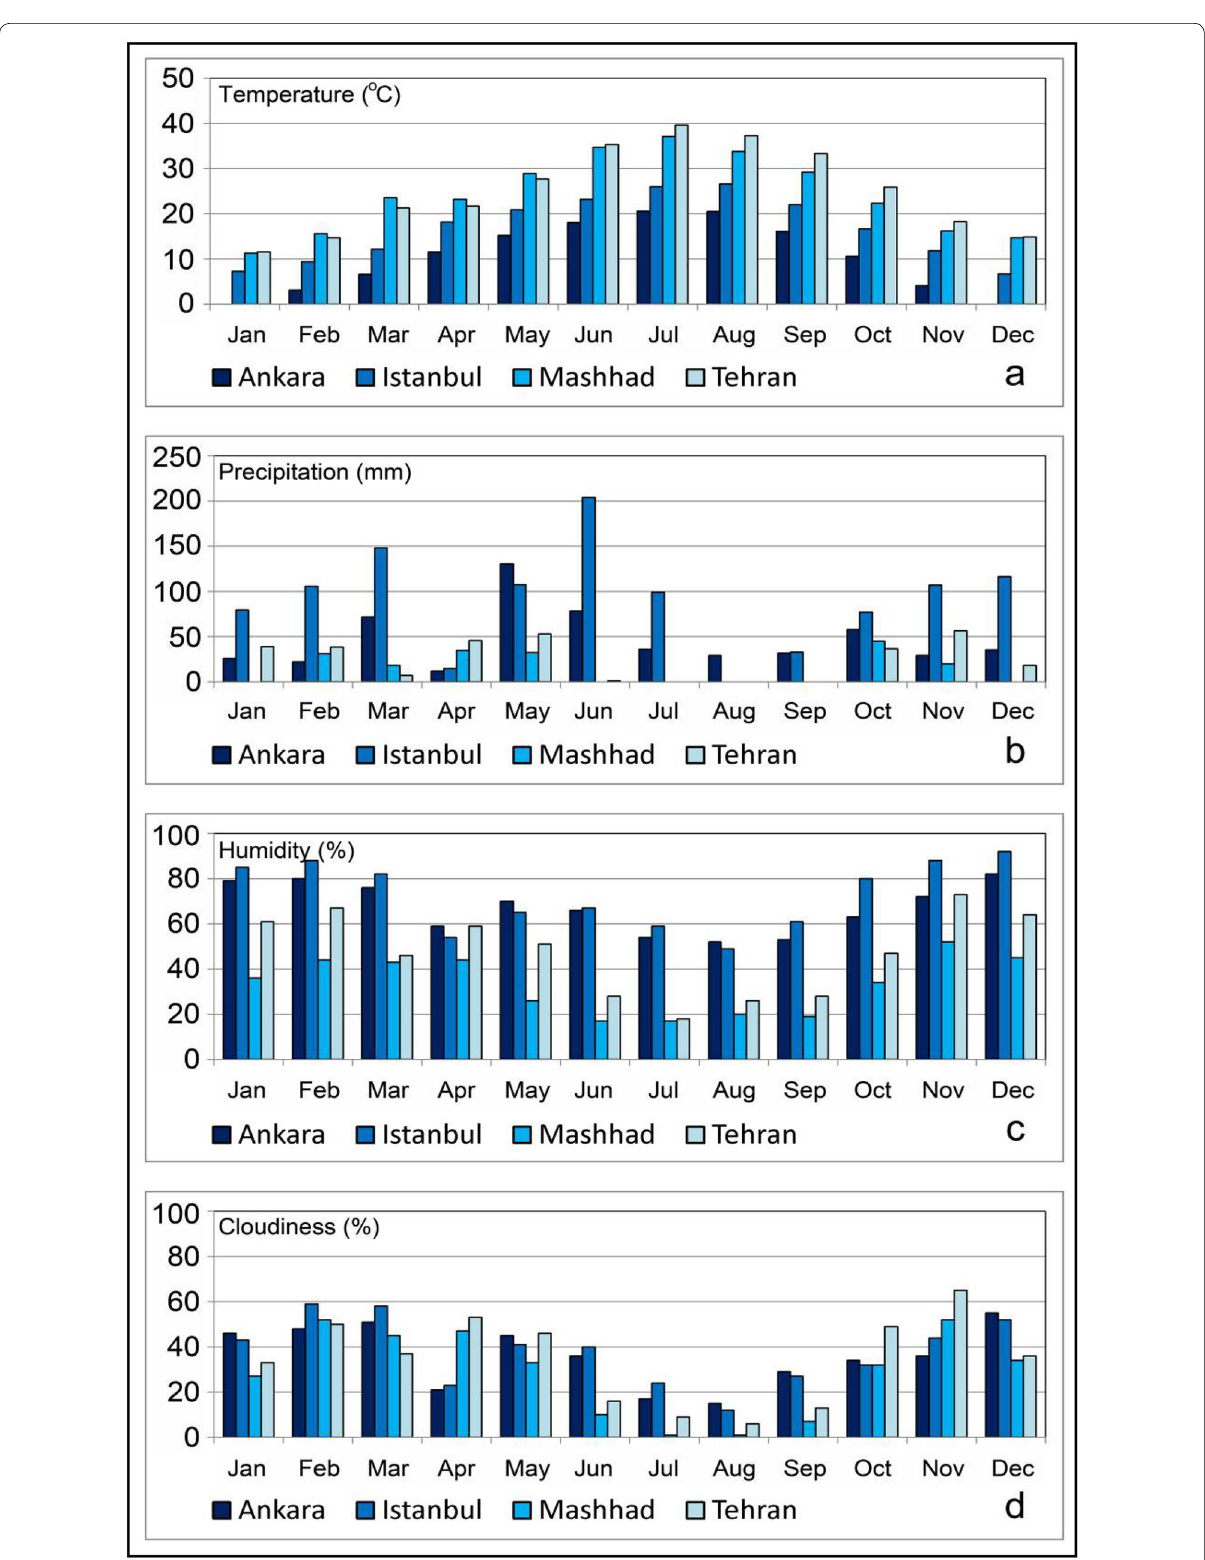
Fig. 7 The percentile contribution of each mean monthly climatic variable to the study areas for a temperature, b precipitation, c relative humidity, and d